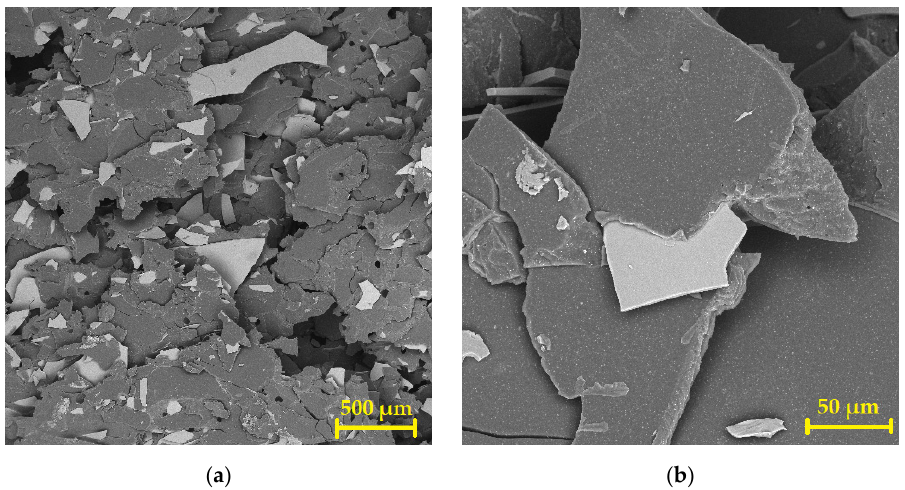
Figure 13. SEM photomicrographs of the coating containing glass flakes (NBR-GF): ( a ) reference coating not exposed to the aggressive environment—50 × magnification; ( b ) NBR-GF after exposure to CH 2 O 2 for 120 days—500× magnification.